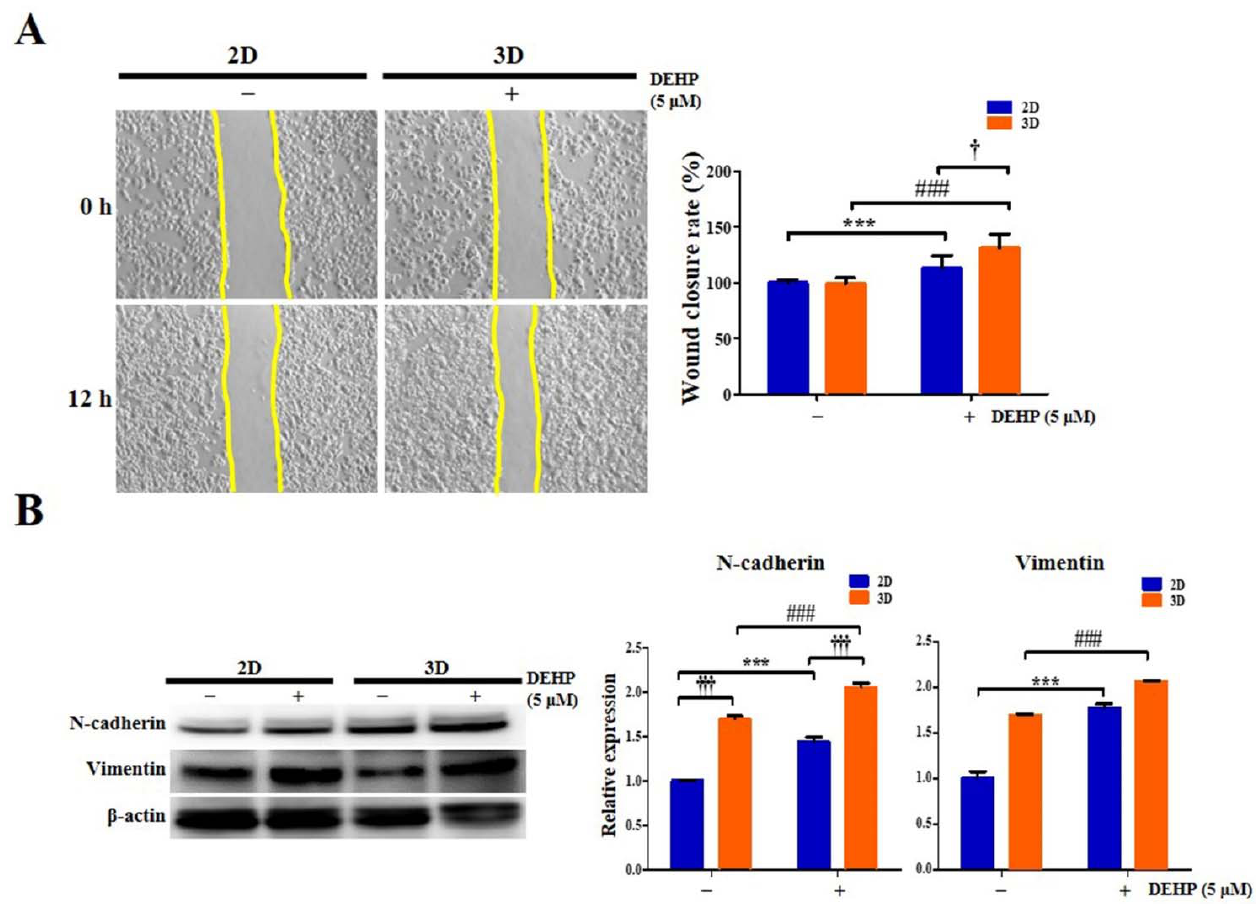
Figure 11. Epithelial-mesenchymal transition (EMT) characteristics of human endometrial epithelial cells are augmented after di-(2-ethylhexyl) phthalate (DEHP) treatment in 3D culture as detected using Western blot analysis. ( A ) Representative photomicrographs (100 × ) of 2D- and 3D-cultured Ishikawa cells migrating to the cell − free space under a phase contrast microscope. Images were captured at 0 and 12 h. The distances between the two edges are scaled for three positions at different times; ( B ) N-cadherin and vimentin protein expression levels. β -actin was used as the internal loading control for data normalization. All data are expressed as relative values against their respective control group. Data represent the mean ± standard deviation of three independent experiments. ***